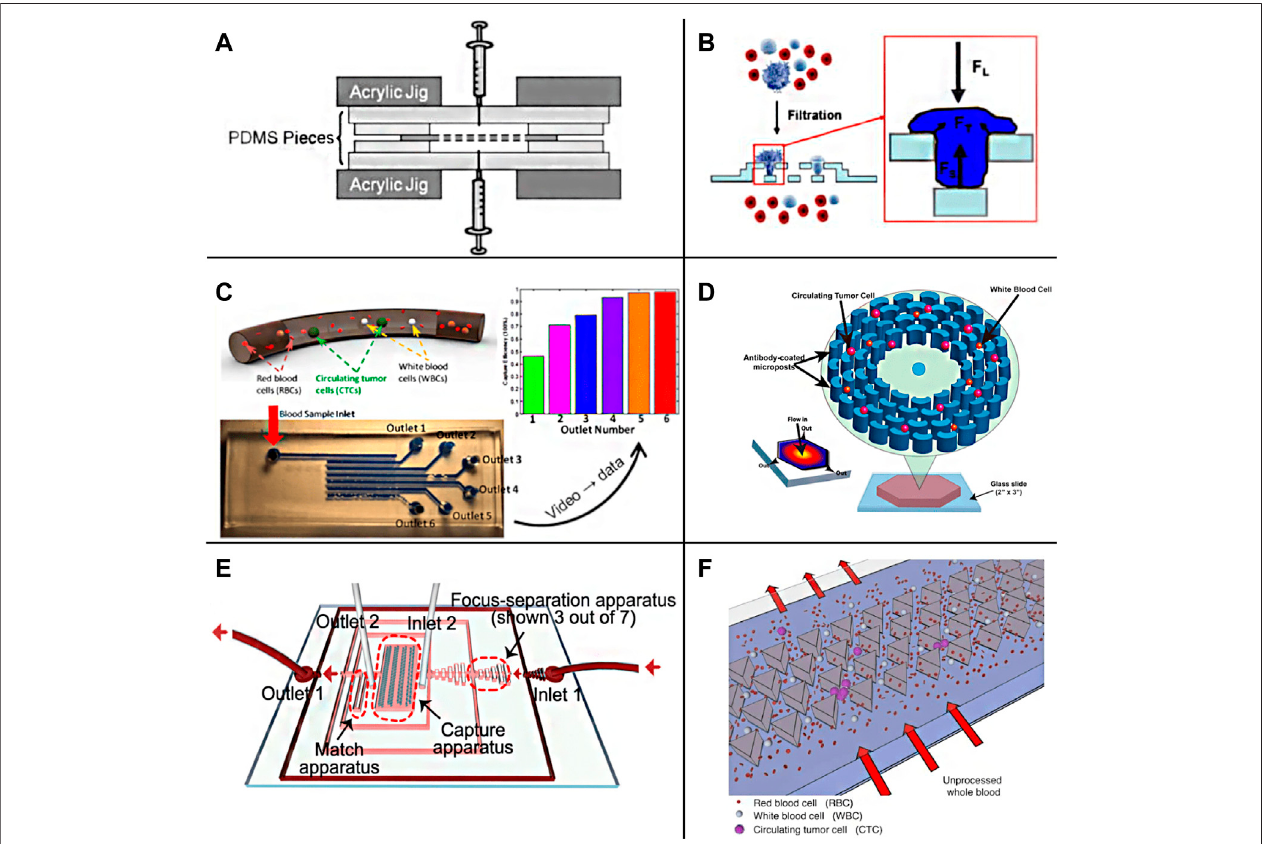
FIGURE 4 | Passive enrichment methods based on physical screening (A) A functional microdevice consists of parylene membrane fi lter (Lin et al., 2010); (B) Filtrationprocessand forces onatrappedcellofthethree-dimensionalmicro fi ltration device(Zhengetal.,2011); (C) Sequential Size-Based Micro fl uidicChip (Renet al., 2018); (D) The OncoBean Chip (Murlidhar et al., 2014); (E) A schematic illustration of the chip combining microscale hydrodynamics and pore sieve principle (Lu et al., 2020); (F) Schematic representation of the Cluster-Chip operation (Sarioglu et al.,